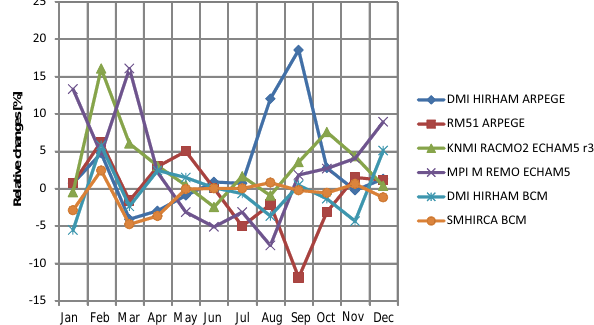
Figure 10. The differences in the percentage of grid cells with a sta- tistically significant trend for data with and without bias